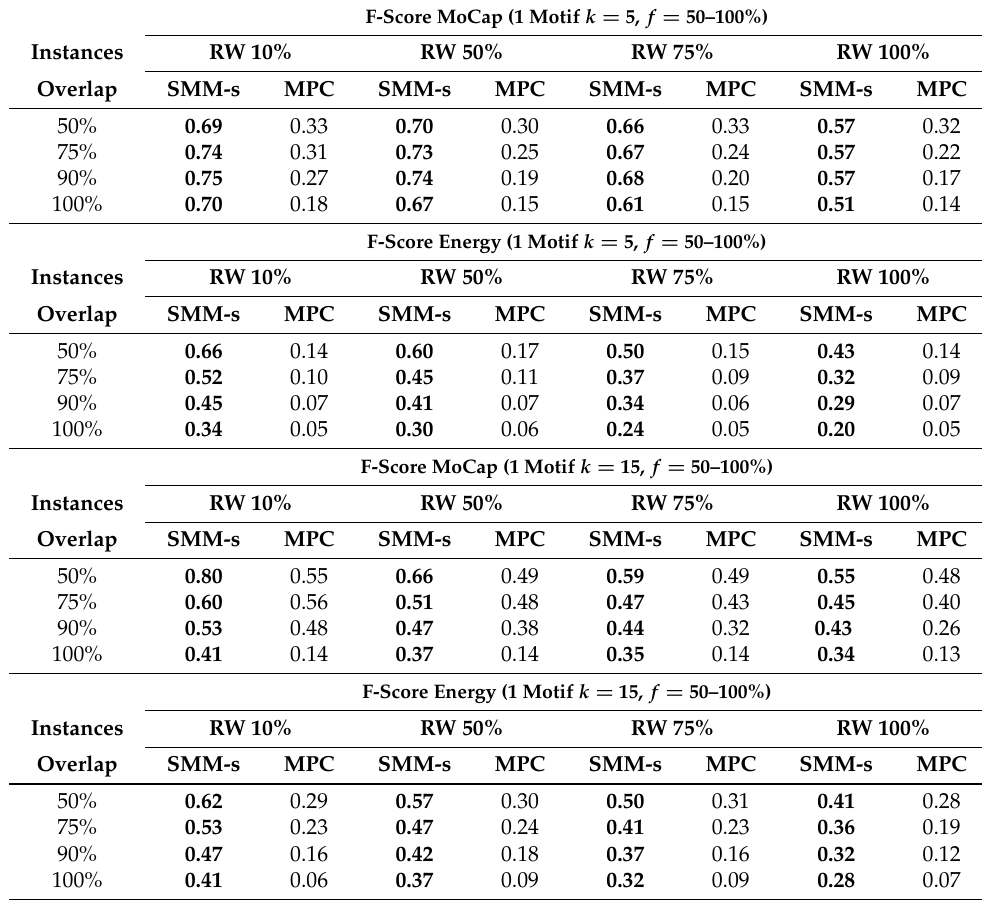
Table 5. F-scores for time series with recurring patterns for varying number of recurrence counts using MoCap (default parameters, various k